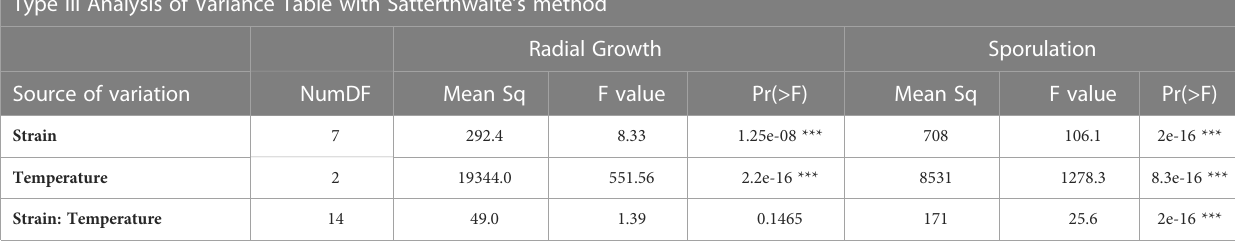
Type III Analysis of Variance Table with Satterthwaite ’ s